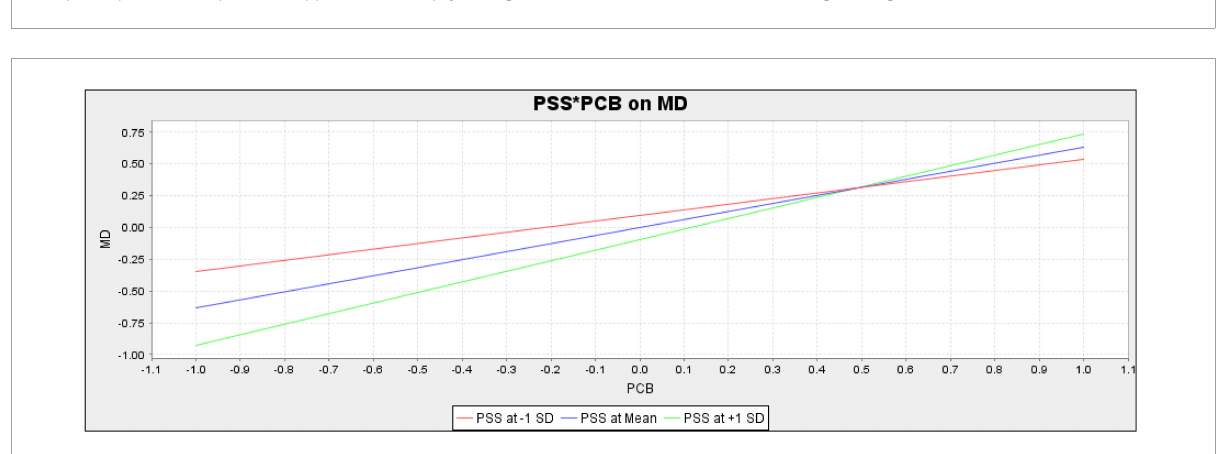
FIGURE3 Slope for perceived supervisor support (PSS) and psychological contract breach (PCB) on knowledge hiding (KH) (moderation).